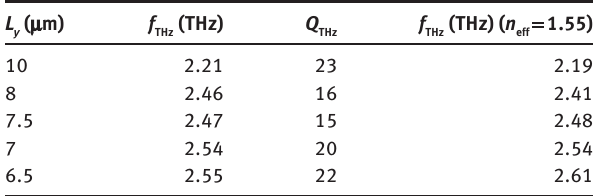
Table 1: Measured central frequency and quality factor